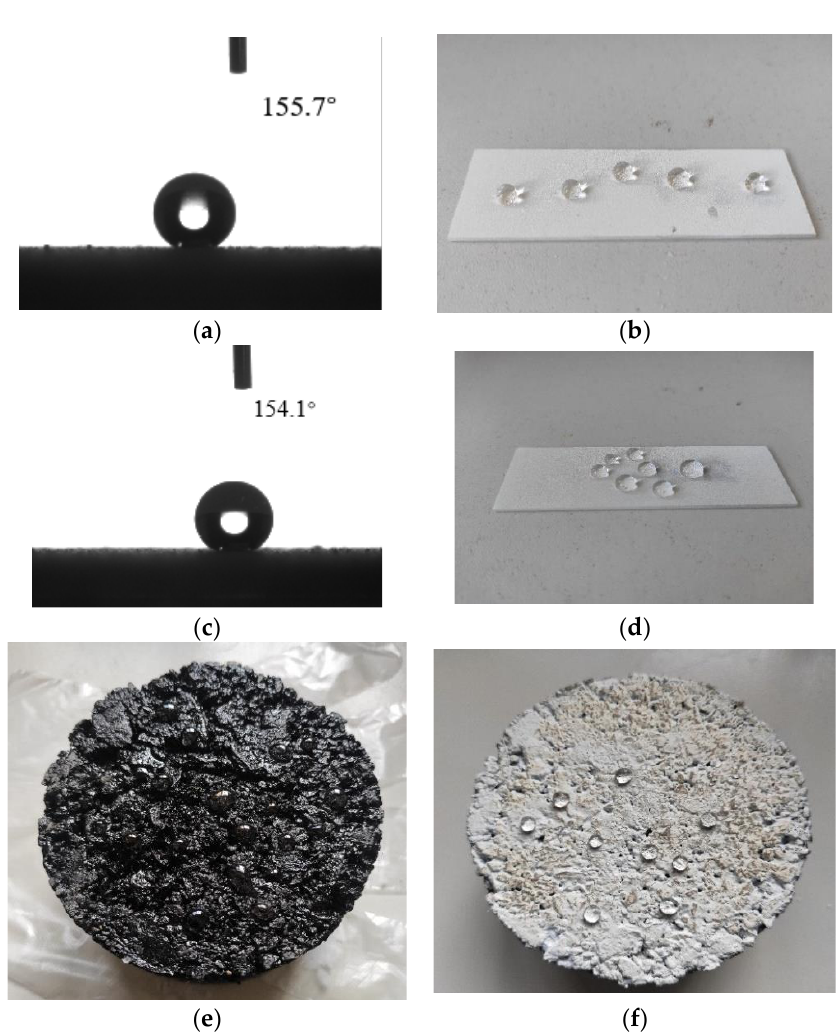
Figure 4. Image of the water contact angle of the sample: ( a ) Contact angle testing picture of S1; ( b ) photo of actual item contact angle of S1; ( c ) contact angle testing picture of cured superhydrophobic coating (PSC); ( d ) photo of actual item contact angle of PSC; ( e ) contact angle of untreated asphalt Marshall specimen; ( f ) contact angle of PSC asphalt Marshall specimen.